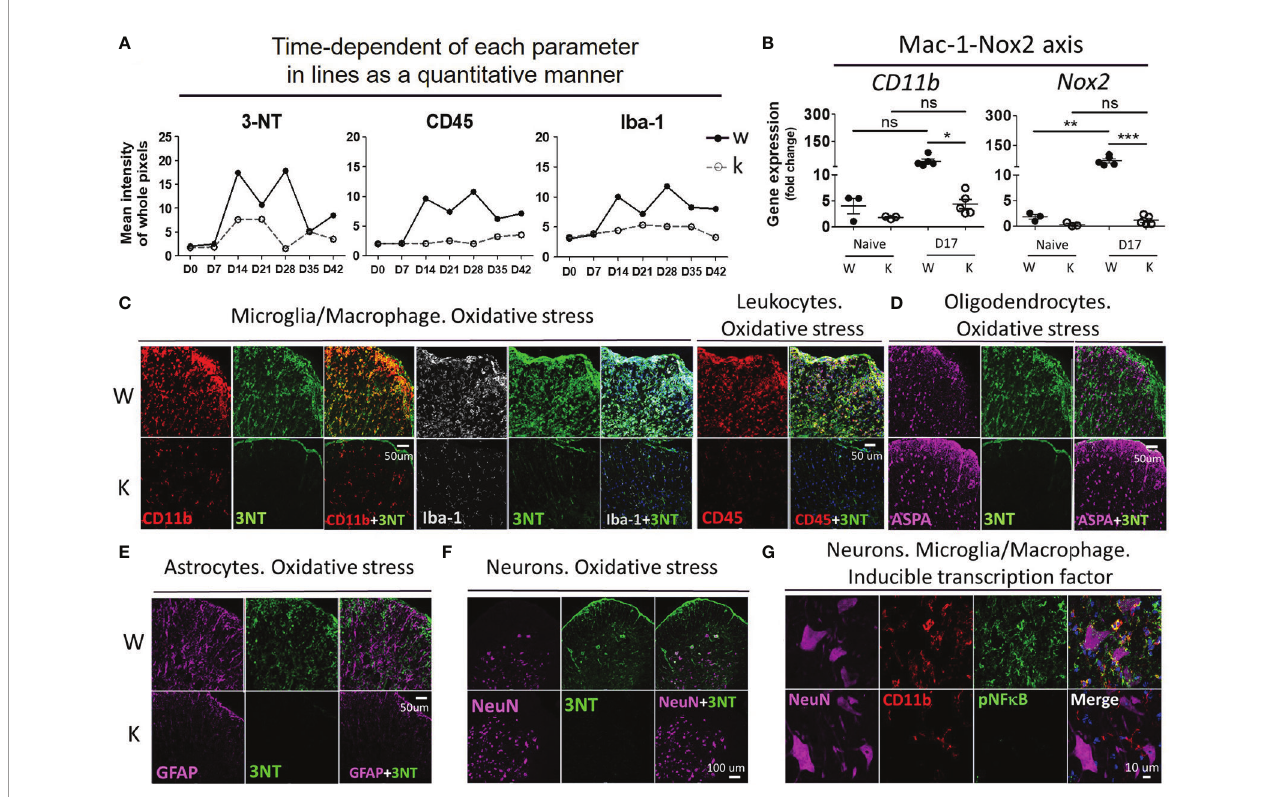
FIGURE 6 | Nox2 de fi ciency largely reduces the production of oxidative stress and the signal of pNF- k B on disease peak (17 dpi) at spinal cord area. (A) Time- dependent of each parameter in lines as a quantitative manner. The mean fl uorescence intensity of whole pixels was measured by Image J. (B) mRNA levels (mean ± SEM) of spinal cord (L4-level section, 0.5 m m thick tissues) at 17 dpi after MOG inoculation were determined by RT-PCR. Cell membrane protein: CD11b and Nox2 , (C) The relationship between 3-NT (3-Nitrotyrosine, oxidative stress marker) signal and Iba-1 (microglia/macrophage), CD45 (leukocytes), CD11b (microglia/ macrophage), (D) ASPA (aspartoacylase, active oligodendrocytes), (E) GFAP (astrocytes), (F) NeuN (total neurons). (G) The relationship between pNF- k B (inducible in fl ammatory transcription factor) and NeuN, CD11b. Genotype: W, Nox2 +/+ ; K, Nox2 − / − . Formalin- fi xed frozen section: 10 m m. Spinal cord level: lumbar fourth. (C – F) marginal and ventral area of spinal cord (white matter); (G) ventral area of spinal cord (gray matter). p value: *** < 0.001, ** < 0.01, * < 0.05, ns, not signi fi